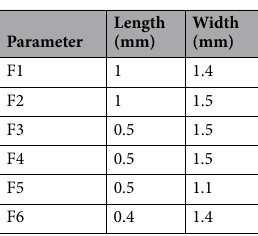
Table 3. Dimensions of the F parameters in the 8 × 32 antenna